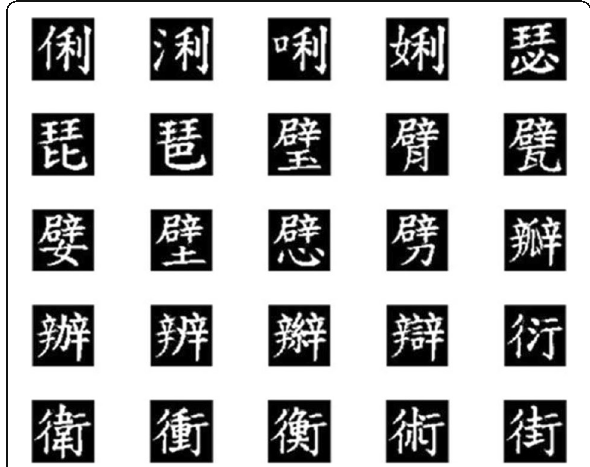
Fig. 5 A set of Chinese characters represented as binary